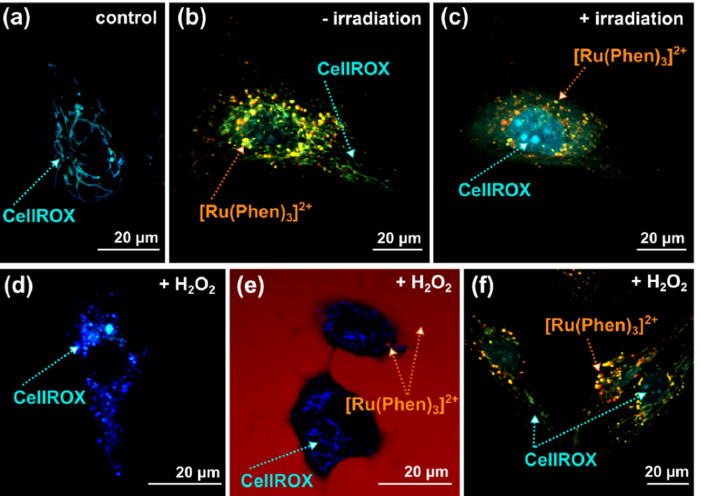
Figure 6. Illustrative confocal microscopy images of U87 MG cells stained with ( a – f ) 1 µM (30 min) CellROX ® Green (cyan and blue) and 200 µM [Ru(Phen) 3 ] 2+ (orange and red). These dyes were applied in the U87 MG cells culture medium for ( e ) 1 and ( b , c , f ) 24 h. ( c ) The cells were irradiated with microscopy (detection time less than 2 min, 2% of the power of the laser: 405 and 488 nm)—the second scan of cells stained with [Ru(Phen) 3 ] 2+ and CellROX ® Green. The photoreaction in- duced oxidative stress. ( d – f ) Extracellular oxidative stress was induced by 200 µM H 2 O 2 .